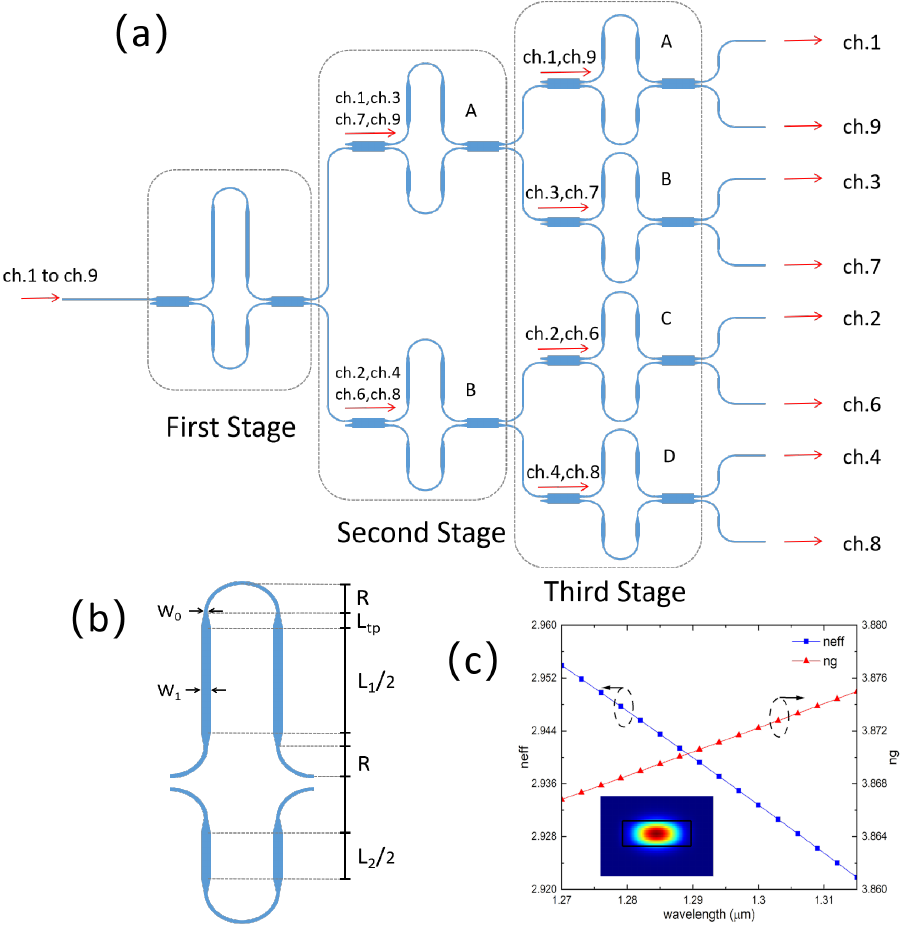
Figure 1. Schematic diagram of ( a ) the 8-channel (de)multiplexer and the demultiplexing process and ( b ) the delay arms in MZI. W 0 = 0.41 µ m, W 1 = 1 µ m, L tp = 5 µ m, R = 10 µ m. ( c ) The simulation result of the waveguide effective index and group index from 1270 nm to 1315 nm wavelength range. dn neff Group index is given by n g = n ef f ( λ ) − λ d λ